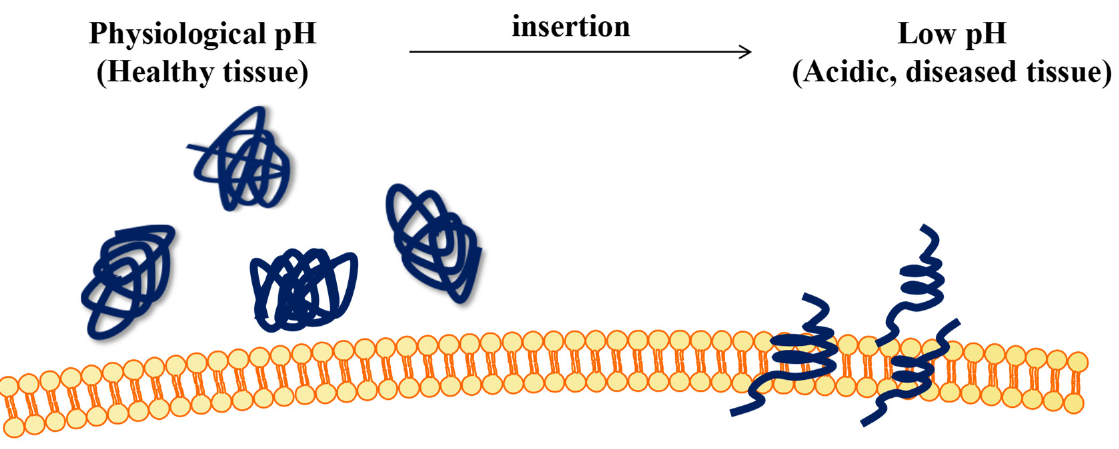
Figure 1. Interaction between pHLIP and cell membrane.